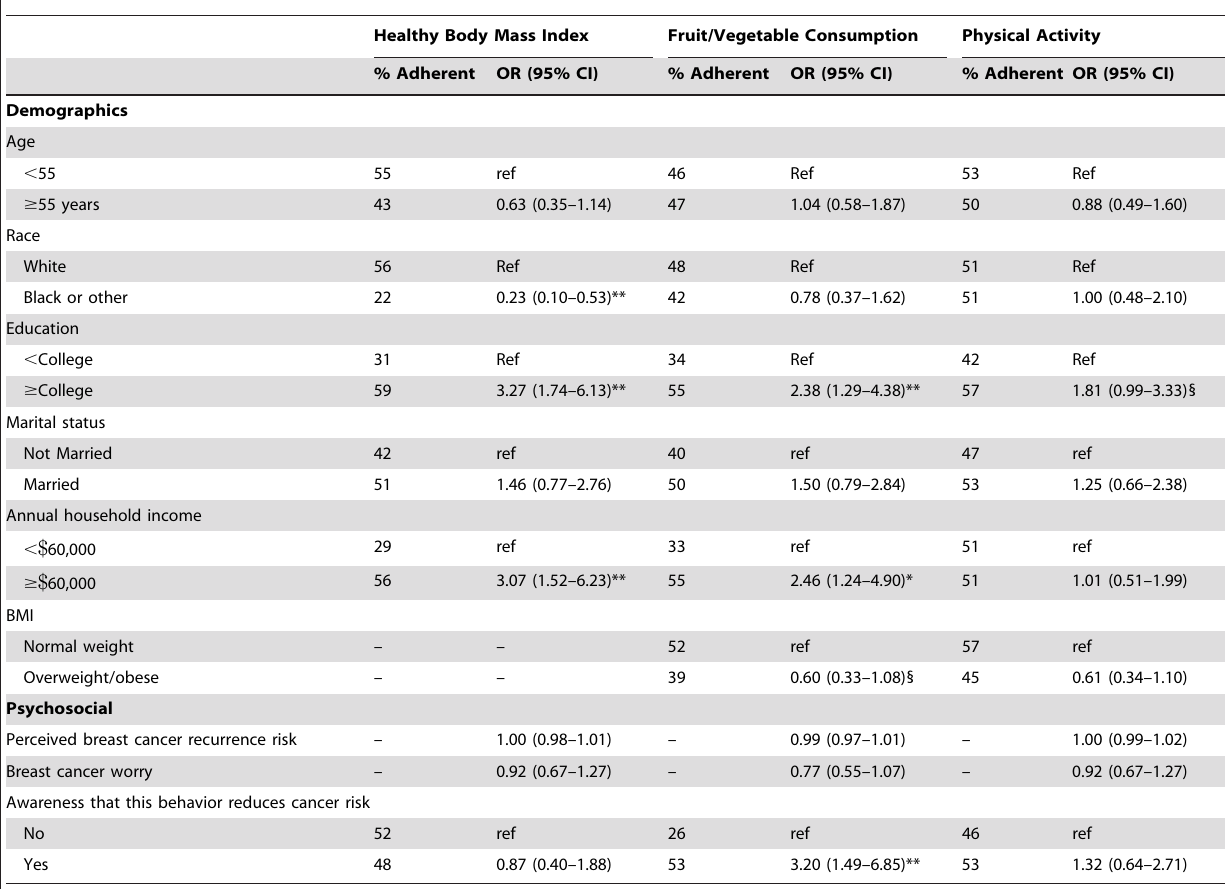
Table 4. Correlates of Meeting Health Behavior Recommendations-Demographics and Psychosocial